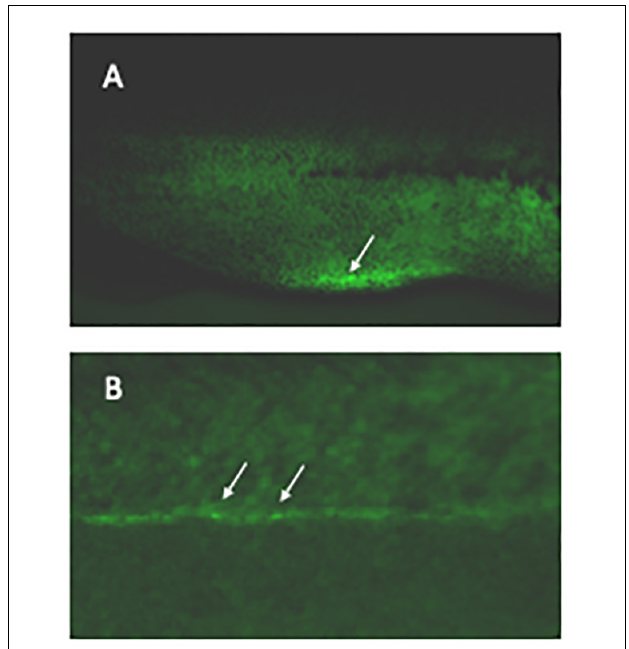
FIGURE 1 | Labeling haematopoietic stem cells in live embryos. Xenopus laevis eggs were microinjected with CRISPR/Cas9 targeting the 3 (cid:48) UTR of runx1 together with a DNA construct containing 400 bp homology arms from either side of the cut site flanking an IRES controlling eGFP expression. Founder embryos were screened for mosaic expression of GFP in the correct regions and 24 grown to adulthood. Their offspring were then screened for germline transmission; two sets of offspring showed strong expression in the vbi ( A , arrowed) and vasculature ( B , examples arrowed) as expected for runx1 at this stage. The transmission rate was 46 and 52% in the 2 sets. An F2 embryo is shown.